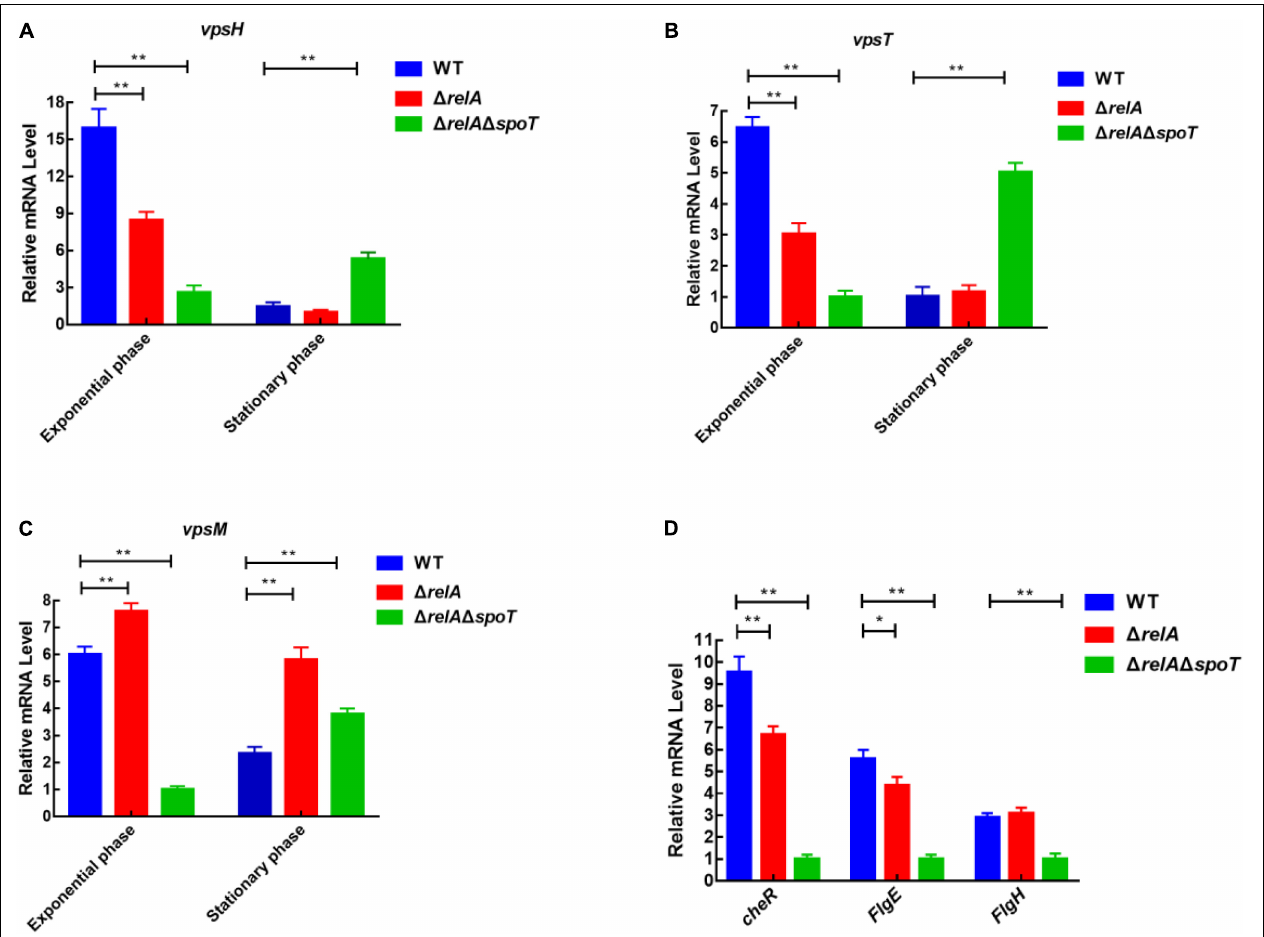
FIGURE 6 | qRT-PCR analysis of transcriptional levels in WT, (cid:49) relA , and (cid:49) relA (cid:49) spoT . (A–C) The relative mRNA levels of EPSs-related genes were detected at low and high cell densities, respectively. (D) The relative mRNA levels of motility-related genes were detected when bacterial cultures entered the exponential phase (OD 600 = 0.6). The results are normalized to the control gene 16S rRNA using the 2 − (cid:49)(cid:49) Ct method. Results are shown as the means ± SD ( n = 3). The blue columns, red columns, and green columns represent WT, (cid:49) relA , and (cid:49) relA (cid:49) spoT , respectively. * indicates p ≤ 0.05, and ** indicates p ≤